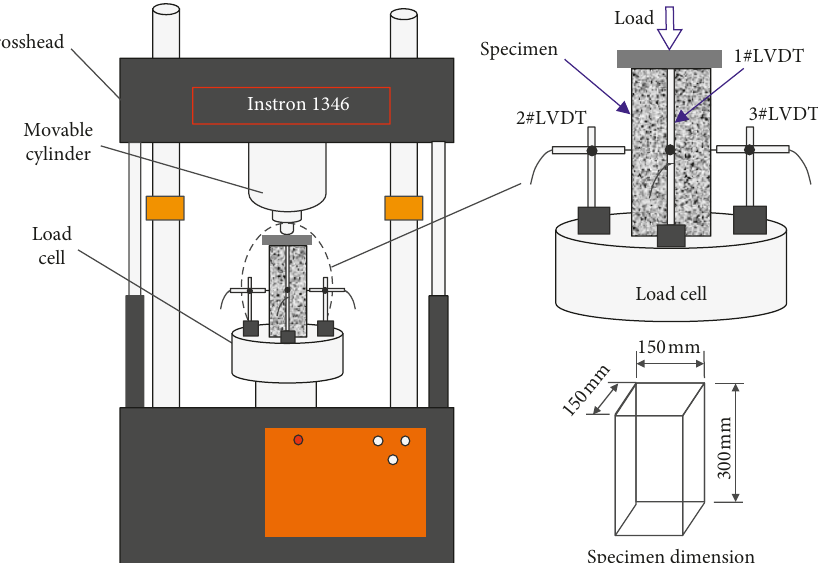
Figure 3: Schematic diagram of experimental setups.